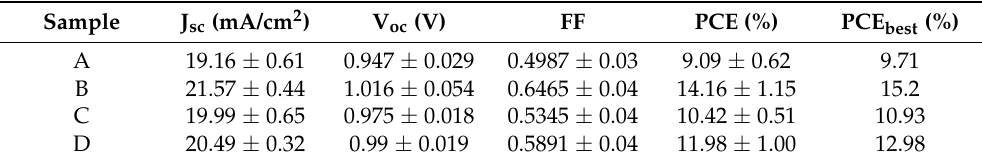
Figure 7. Statistical values of ( a ) V oc , ( b ) J sc , ( c ) FF and ( d ) PCE of PSCs based on (A) bare TiO 2 NR film, and TiCl 4 -treated NR films with annealing temperature of (B) 150 ◦ C, (C) 300 ◦ C and (D) 450 ◦ C, respectively. Table 1. Average performance parameters of PSCs based on (A) bare TiO 2 NR film, and TiCl 4